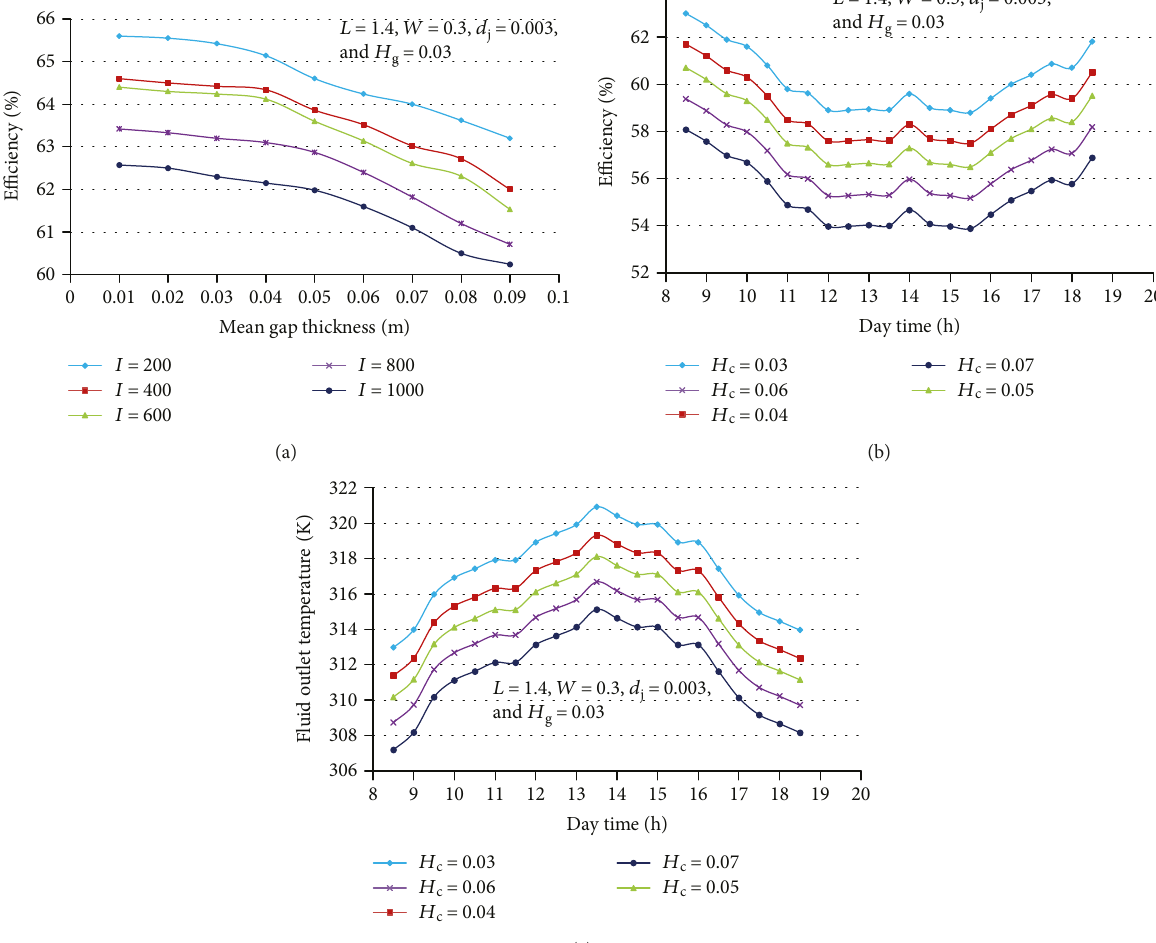
) of the proposed solar air heater. c . (c) Hourly air outlet c